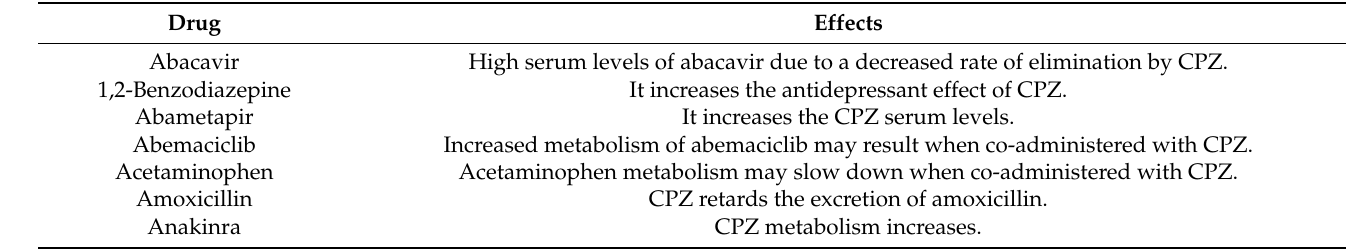
Table 2. The effects of co-administering CPZ with other drugs [69]. Drug